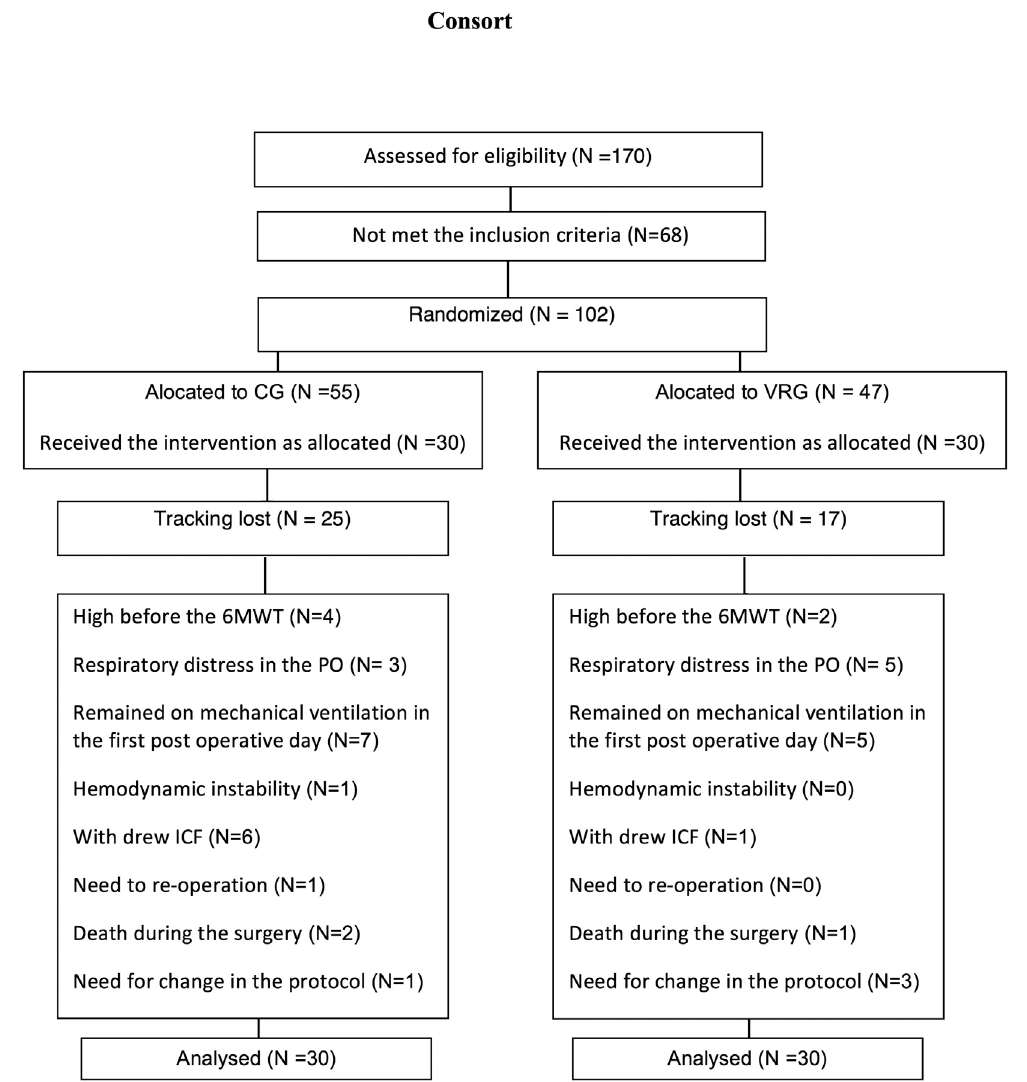
Fig. 1 – Diagram representing the flow of participants in each study